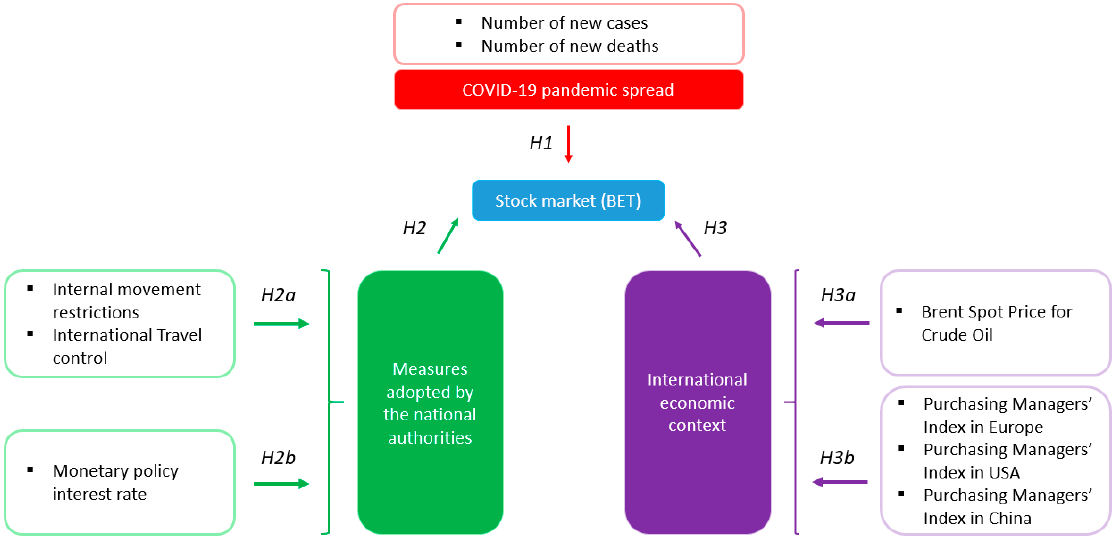
Figure 1. Research framework. Source: authors’ contribution.